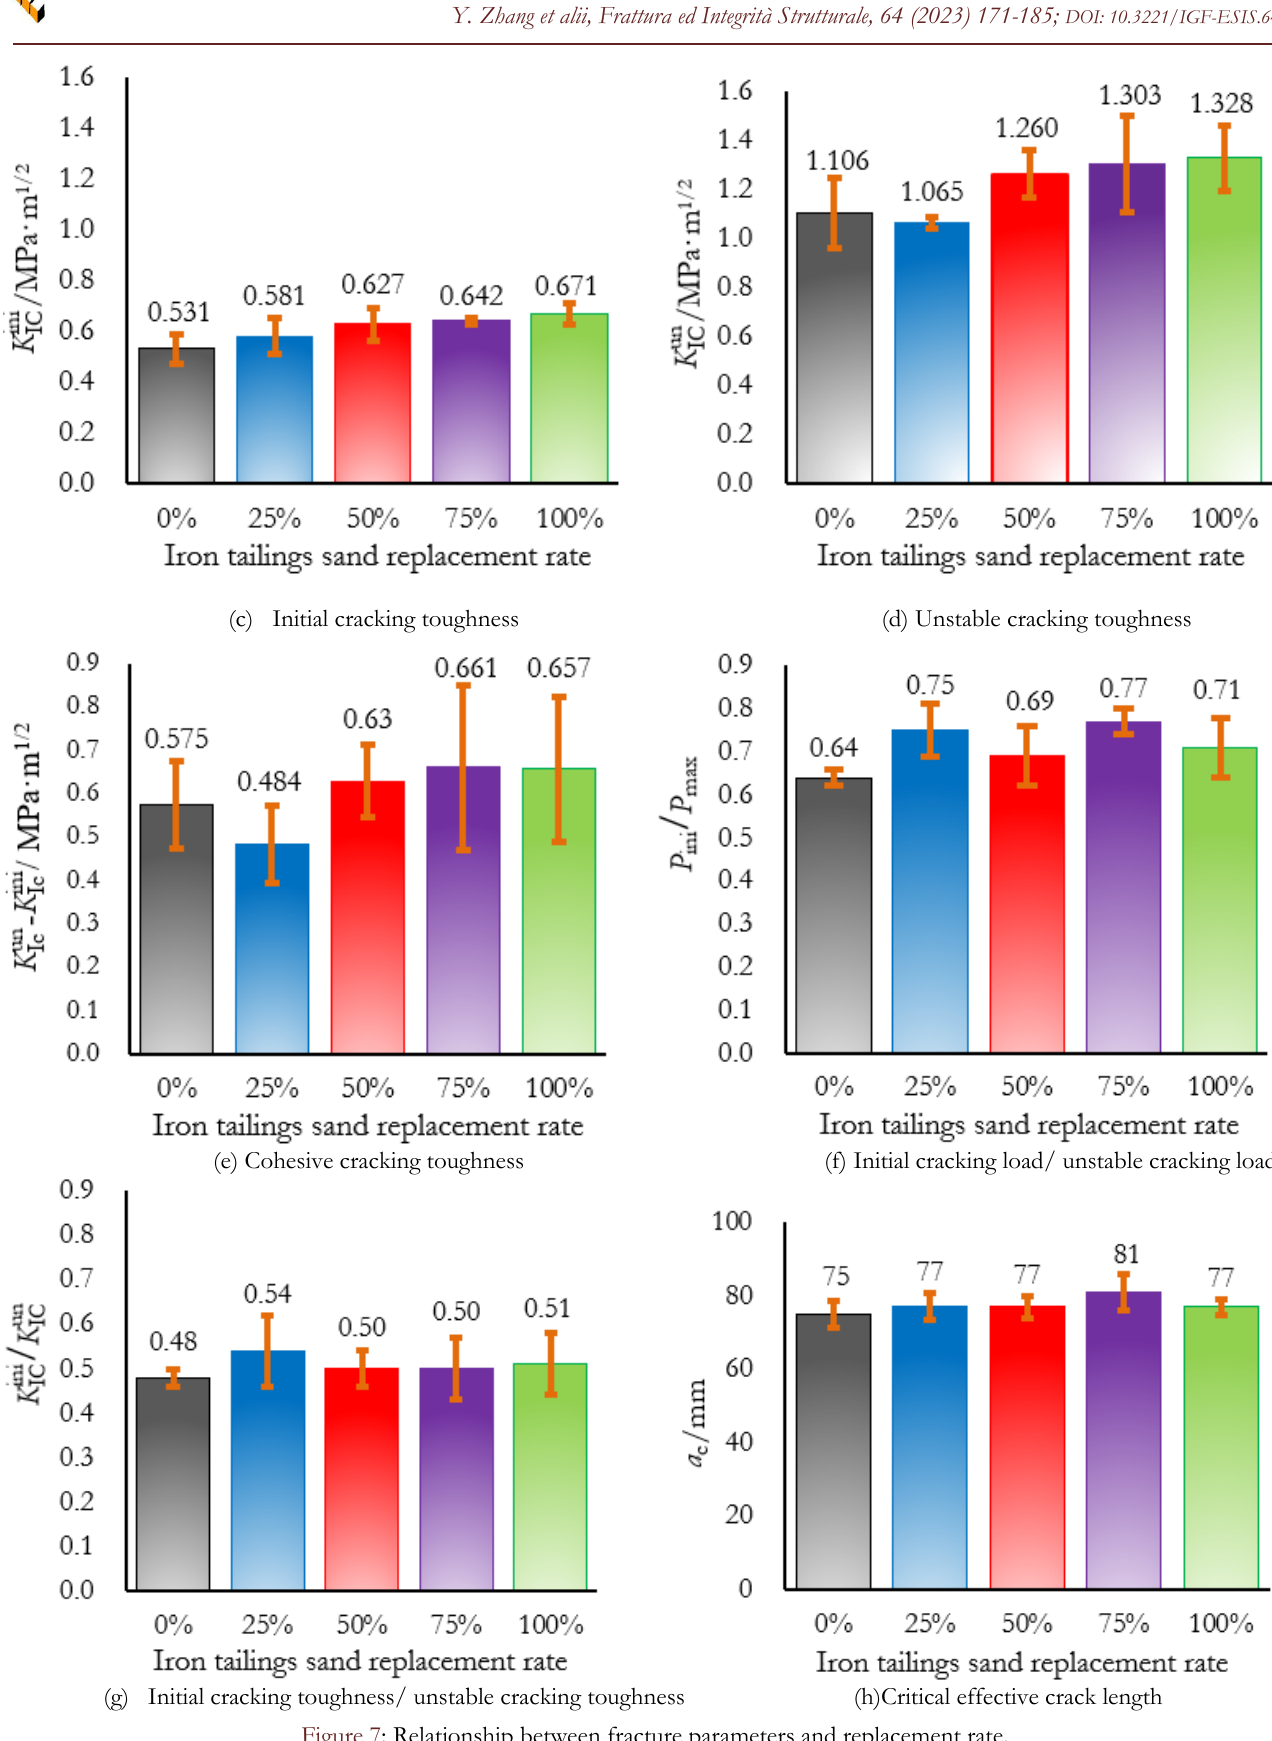
Figure 7: Relationship between fracture parameters and replacement